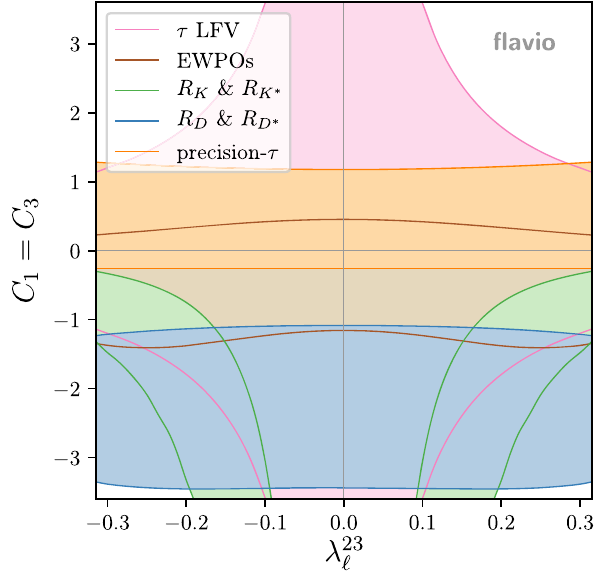
Fig. 7 Likelihood contours at 2 σ for various sets of observables for the scenario with mostly third generation couplings defined in Eq. (18)